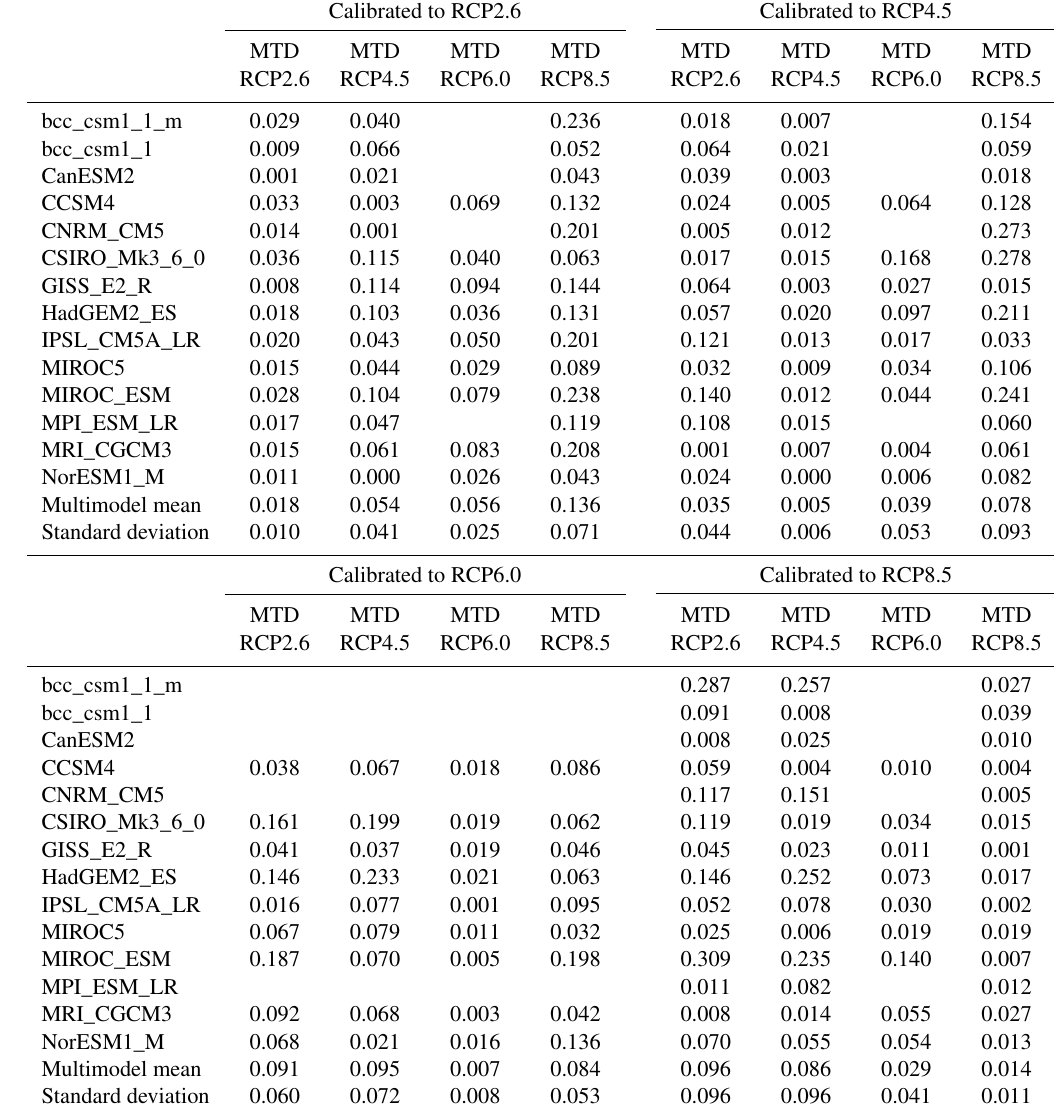
Table B1. Modulus of mean temperature deviations over the period 2071–2100 (MTD) for PH99 from the corresponding AOGCM. In the first four columns, PH99 is calibrated to RCP 2.6. In the second four columns, PH99 is calibrated to